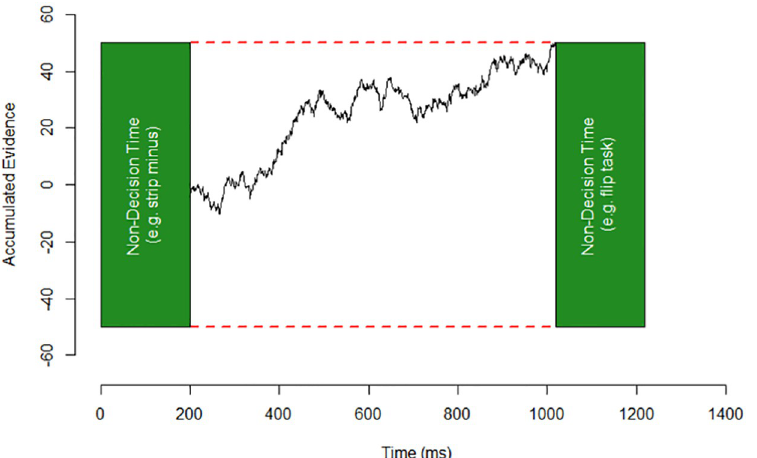
Fig 2. Decision model. Individuals select an option when an internal noisy decision variable (black trace) accumulates up to one of the thresholds (red dashes). Non-decision times are constant (green rectangles) and include initial encoding of the stimulus and response-related